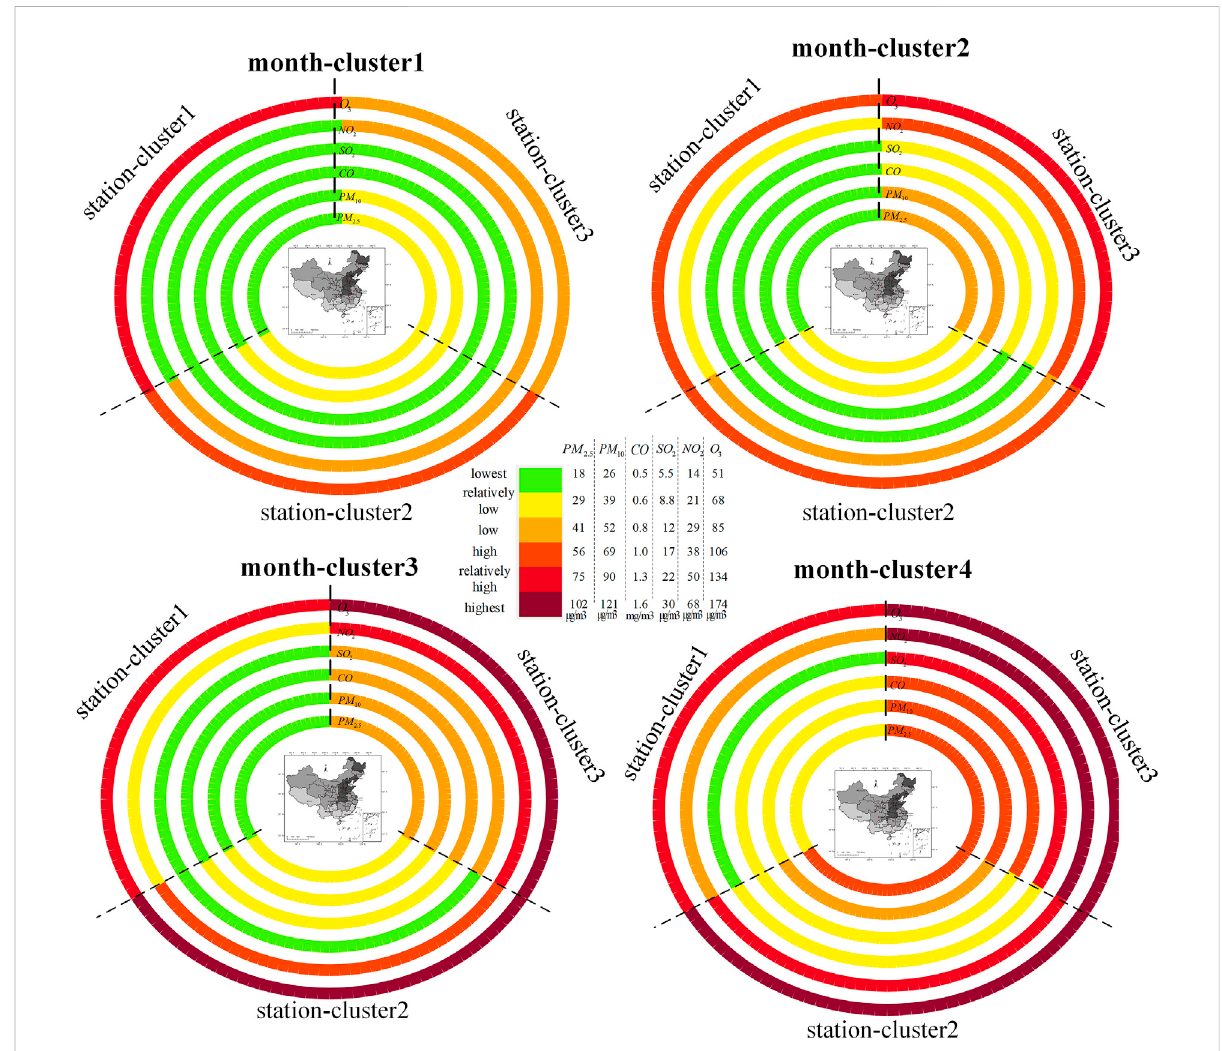
FIGURE 9 Temporal heterogeneity of relationships among six air pollutants from the perspective of month clusters; the map indicates spatial distribution of station clusters with coverage indicated by provinces of corresponding cities (stations) in that station